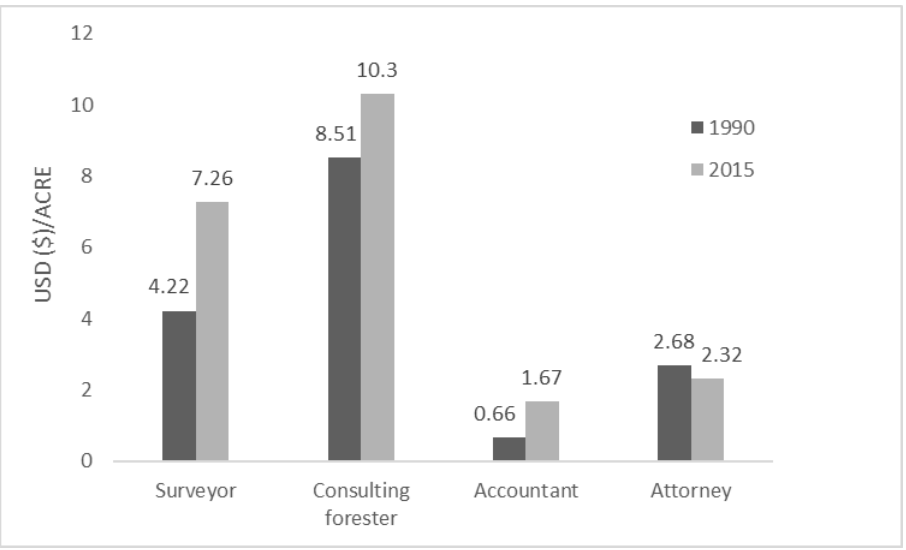
Figure 4. Mean expenditures for Fees for Professional Services of landowners who incurred expenses.